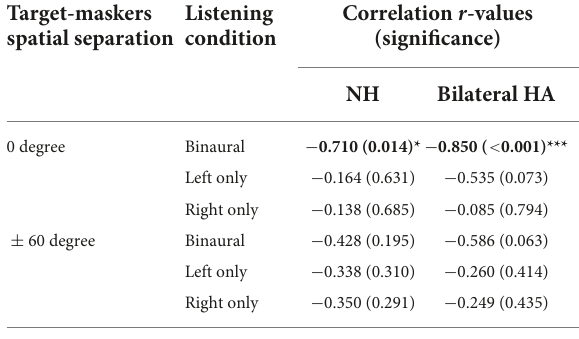
TABLE 2 Regression coefficients between voice gender release from masking (VGRM) and binaural pitch fusion range widths for NH and bilateral HA user groups in each spatial separation and listening condition.